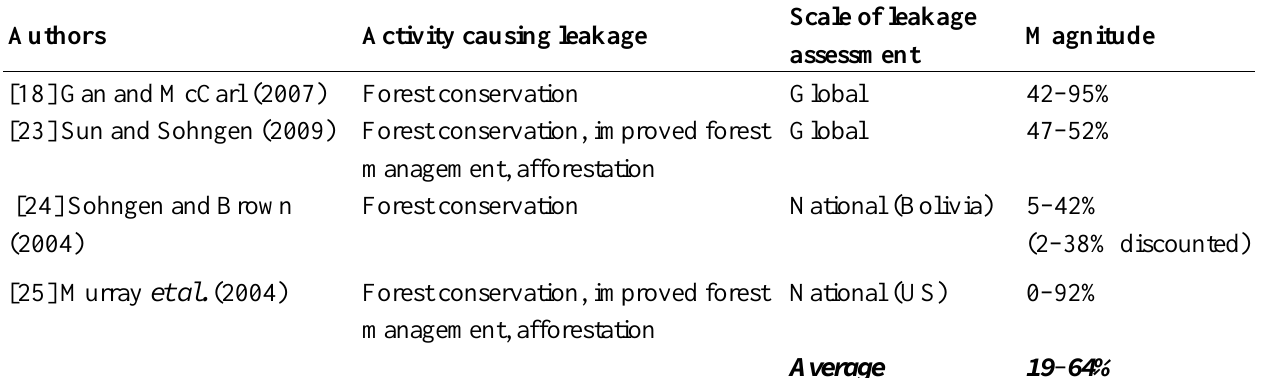
Table 1. Different scientific publications estimating leakage effects of forest conservation activities on regional, national or global scale. Average indicates the average of all low vs. all high values. Squared brackets indicate the reference as presented in the reference